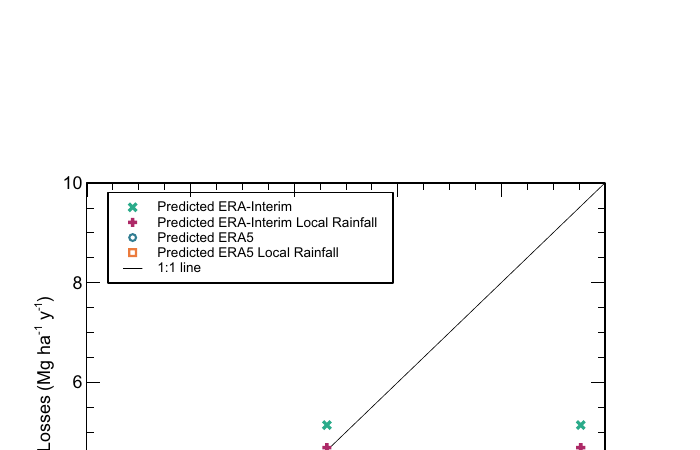
Figure 7. Measured and predicted soil losses (Mg ha −1 y −1 ) for reference soil erosion sites (Table 2) according to ERA-Interim and ERA5 datasets, and local rainfall measurements.